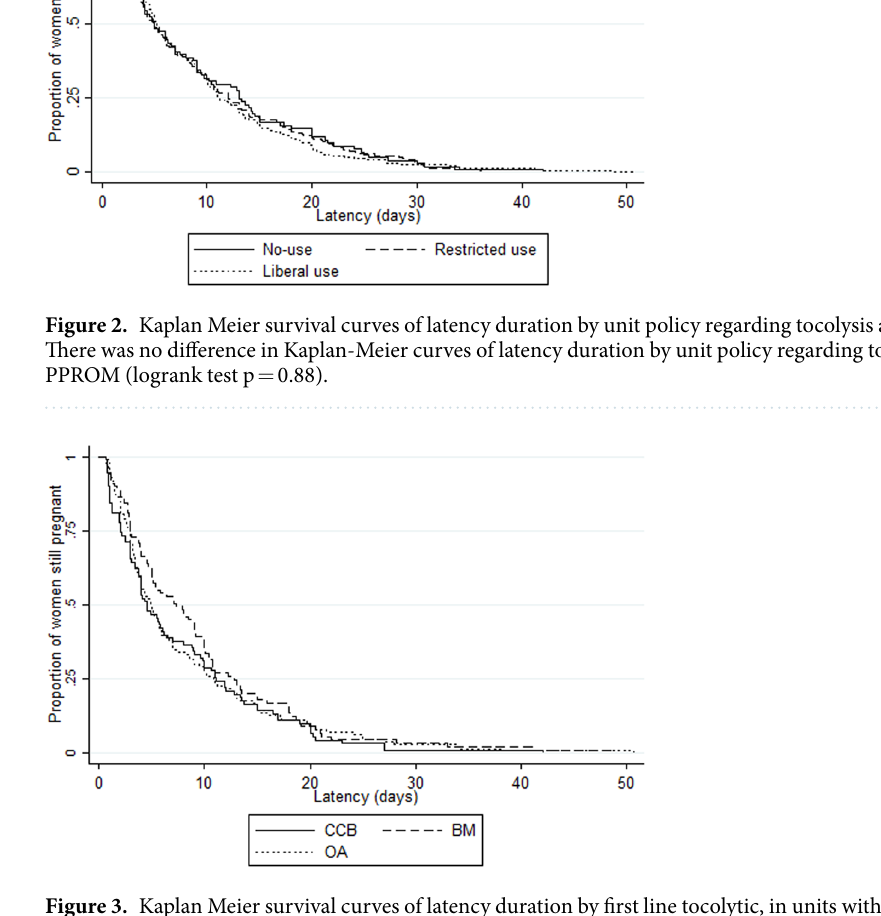
Figure 3. Kaplan Meier survival curves of latency duration by first line tocolytic, in units with a liberal policy of tocolysis after PPROM. BM: betamimetic, CCB: calcium channel blocker, OA: oxytocin antagonist. There was no difference in Kaplan-Meier curves of latency duration by first line tocolytic (logrank test p = 0.43) in units with a liberal policy of tocolysis after